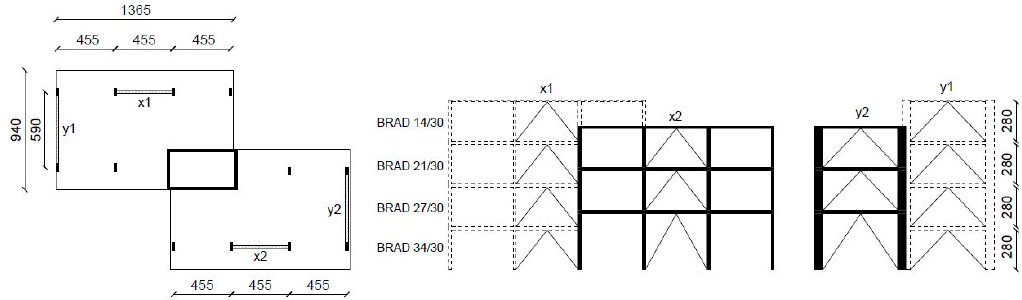
Figure 8. Distribution of dissipative device in plan and elevation.